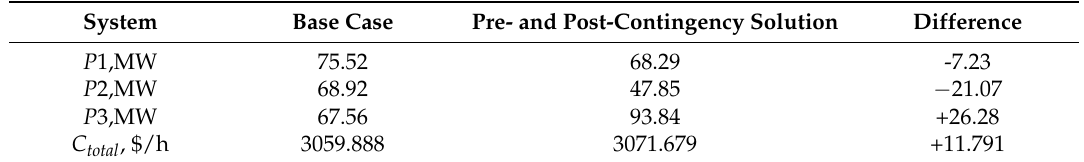
Table 4. Pre- and post-contingency solutions: 6-bus power system.